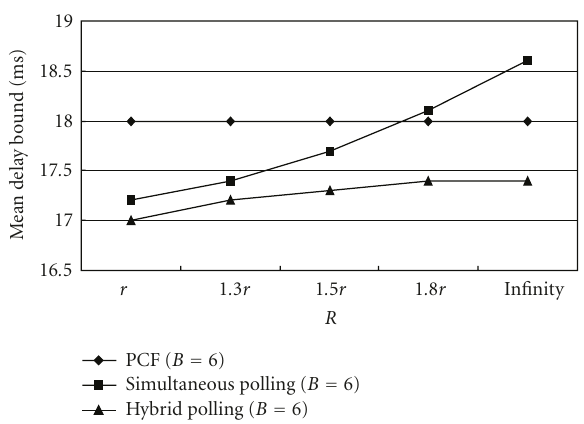
Figure 7: Mean delay bounds when the light tra ffi c load ( B = 6) is imposed on IEEE 802.11a wireless LAN with 30 STAs.